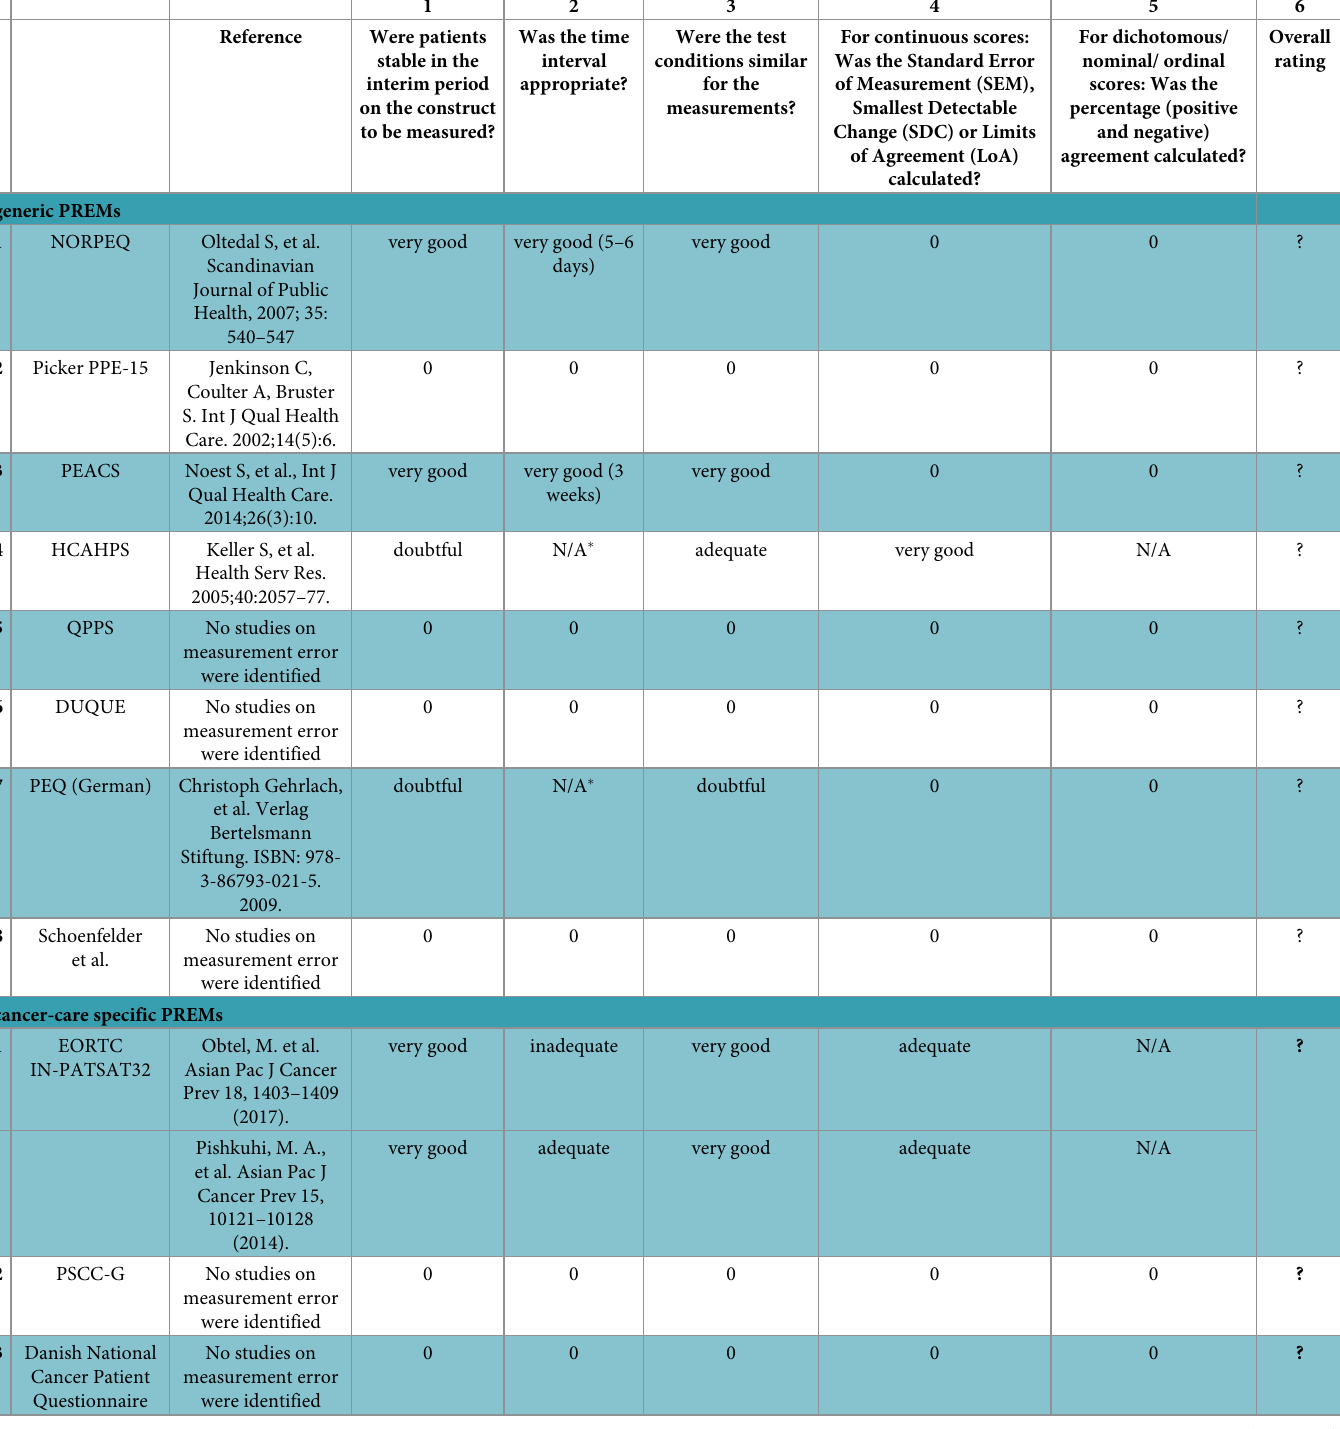
Table 9. Results of analyses for measurement error of German-language PREMs. Rating according to COSMIN